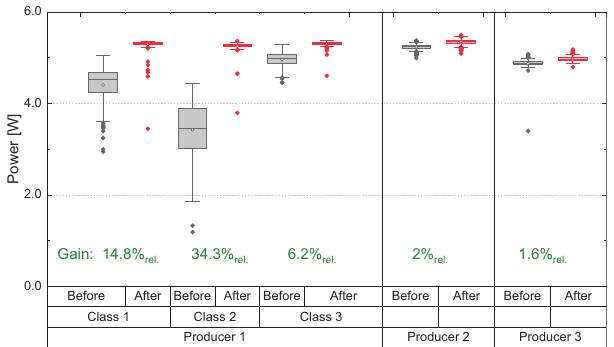
Fig. 1. Ef fi ciency gains for the different used cell classes (taken from [5]).